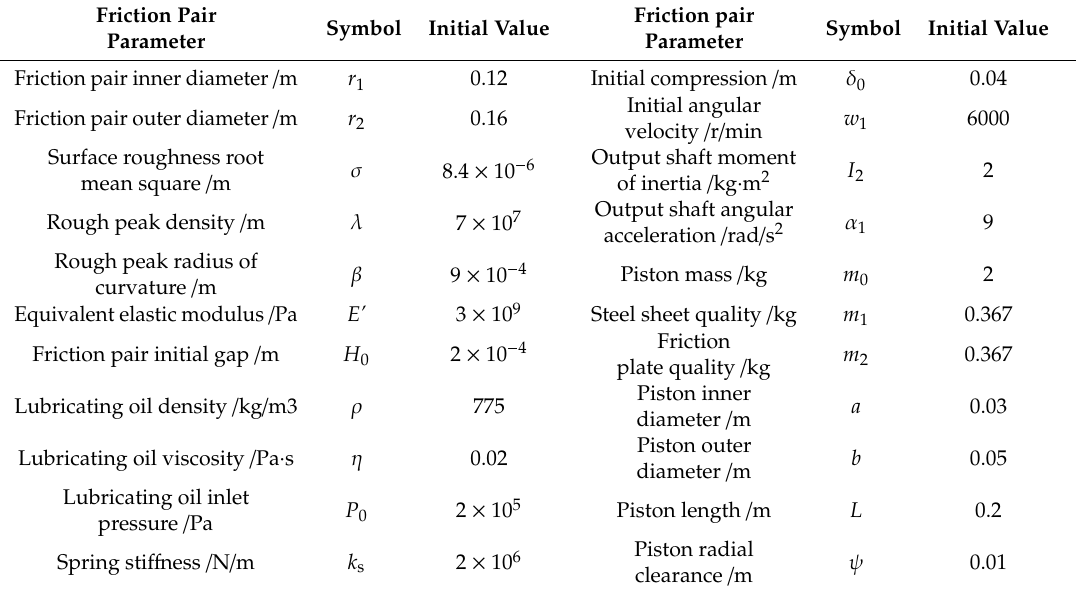
Table 1. Simulation